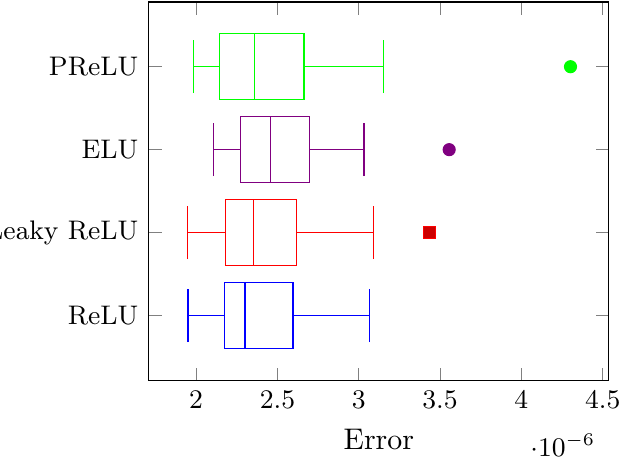
Figure 11. Comparison of activation